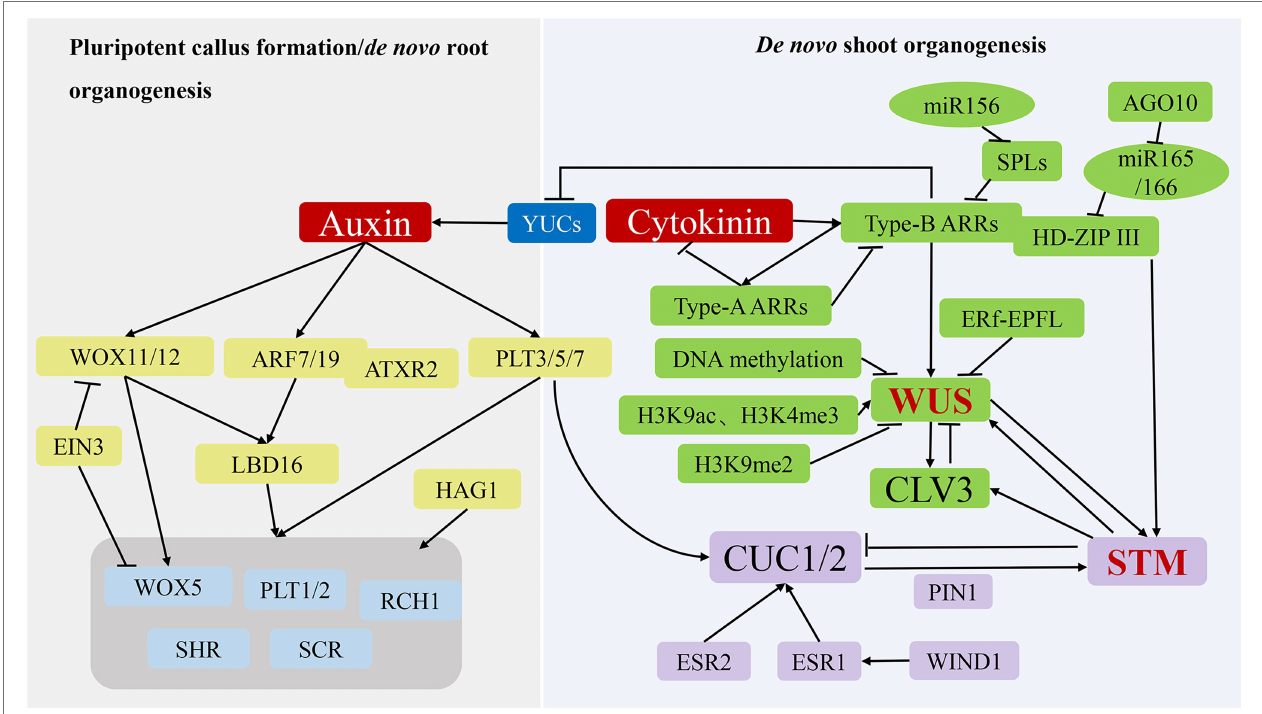
FIGURE 3 | Molecular mechanisms of de novo organogenesis in tissue culture. During the process of pluripotent callus formation or de novo root organogenesis (left panel), YUC-mediated auxin acts as a key regulator to activate WOX11/12 , ARF7/19 and PLT3/5/7 expression, after which their translated products directly or indirectly promote the expression of genes, including WOX5 , PLT1/2 , SHR , SCR , and RCH1 , to induce pluripotent callus or root apical meristem formation. During the process of de novo shoot organogenesis (right panel), two pathways (WUS-CLV3 and STM-CUC) establish negative-feedback loops and play critical regulatory roles. The WUS-CLV3 pathway is mainly regulated by DNA methylation, histone modification, and hormone signalling. CK activates the expression of type-B ARRs to stimulate WUS expression, whereas type-B ARRs repress YUC-mediated auxin biosynthesis. In the STM-CUC pathway, STM expression is promoted by CUC1 and CUC2, both of which have their expression upregulated by PLT3/5/7, ESR1, ESR2, WIND1, and PIN1. Moreover, WUS and STM interact directly to activate CLV3 expression, suggesting that the two pathways converge and coordinate to control shoot